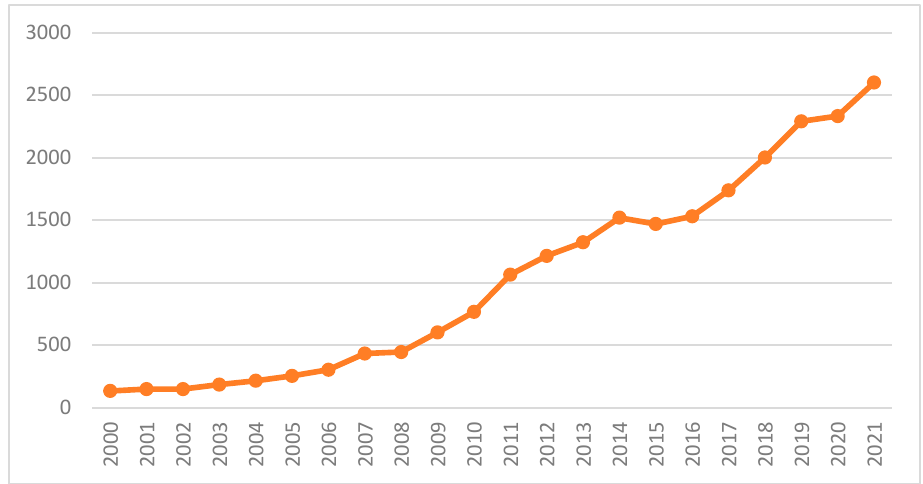
Figure 4. The dynamics of publication activity on energy consumption issues (based on Scopus data).